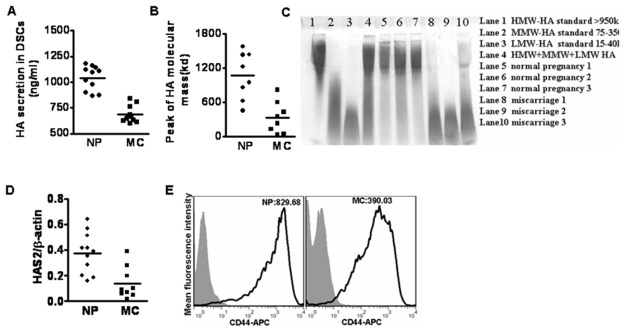
Differential expression of HA, HAS2 and CD44 in DSCs from normal pregnancy and unexplained miscarriage.(A) Primary DSCs from normal pregnancy and unexplained miscarriage were seeded at 1×106 cells/ml in cell culture plates and cultured for 72h. The DSC supernatants were collected and measured by ELISA. Each dot represents results from different sample. (B, C) Molecular size of HA produced by DSCs from normal pregnancy and unexplained miscarriages was displayed through electrophoresis on polyacrylamide gels. Histogram showed the relative molecular mass of HA as determined by using ImageJ software. Data represent the mean ±SE of three independent experiments with a total of 8 samples from unexplained miscarriage and 8 samples from normal early pregnancy. (C) is one representative picture. (D) Primary DSCs from normal pregnancy and unexplained miscarriage were obtained and subjected to real time RT-PCR. HAS2 mRNA level in DSCs was compared between normal pregnancy and unexplained miscarriage. HAS2 mRNA level in DSCs from normal pregnancy was higher than that from unexplained miscarriage. (E) FCM analysis of the expression of CD44 on DSCs from normal and miscarriage. Data are mean ± SE from 4 repeated experiments, respectively. NP is normal pregnancy, and MC is unexplained miscarriage.